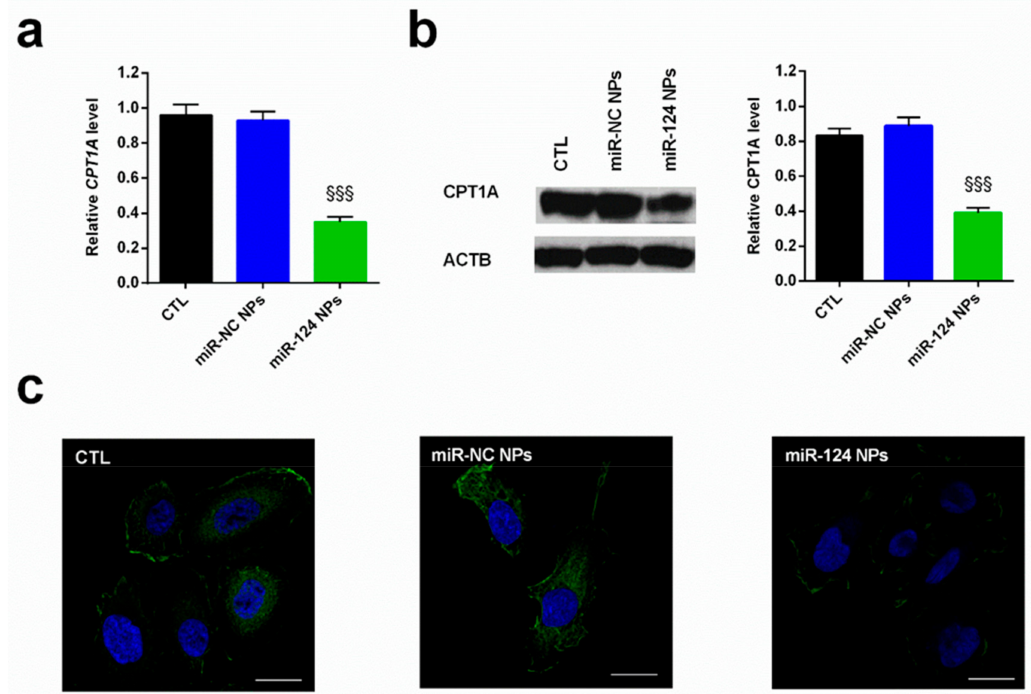
Figure 4. Expression of CPT1A in the PC3 cells in the presence of nanocomplexes. Cells were cultured for 24 h after transfection with miR-124-NPs or miR-NC-NPs at a 10:1 N / P ratio. The untreated cells were used as control (CTL). ( a ) miRNA target level (CPT1A) was quantified by quantitative real-time PCR (qPCR) and normalized to actin (ACTB) as a housekeeping gene. The comparative cycle threshold (CT) method (2 − ∆∆ C t ) was applied to calculate relative di ff erences in qPCR results. ( b ) Western blot analysis of CPT1A protein was performed on total PC3 protein fraction. The protein expression was normalized to the housekeeping protein ACTB. The bars represent the mean ± SD, n = 3. Statistically significant variations: §§§ p < 0.001 miRNA versus miR-NC and CTL. ( c ) Representative fluorescent images of CPT1A expression. Immunofluorescence stain was performed with a FITC-labeled secondary antibody and counterstained with DAPI. Magnification 40 × , scale bar is 50 µ